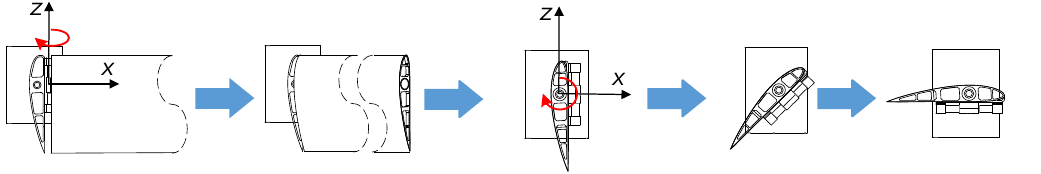
Figure 5. Folding wing deployment process (non-fixed-axis – fixed-axis stepwise deployment).